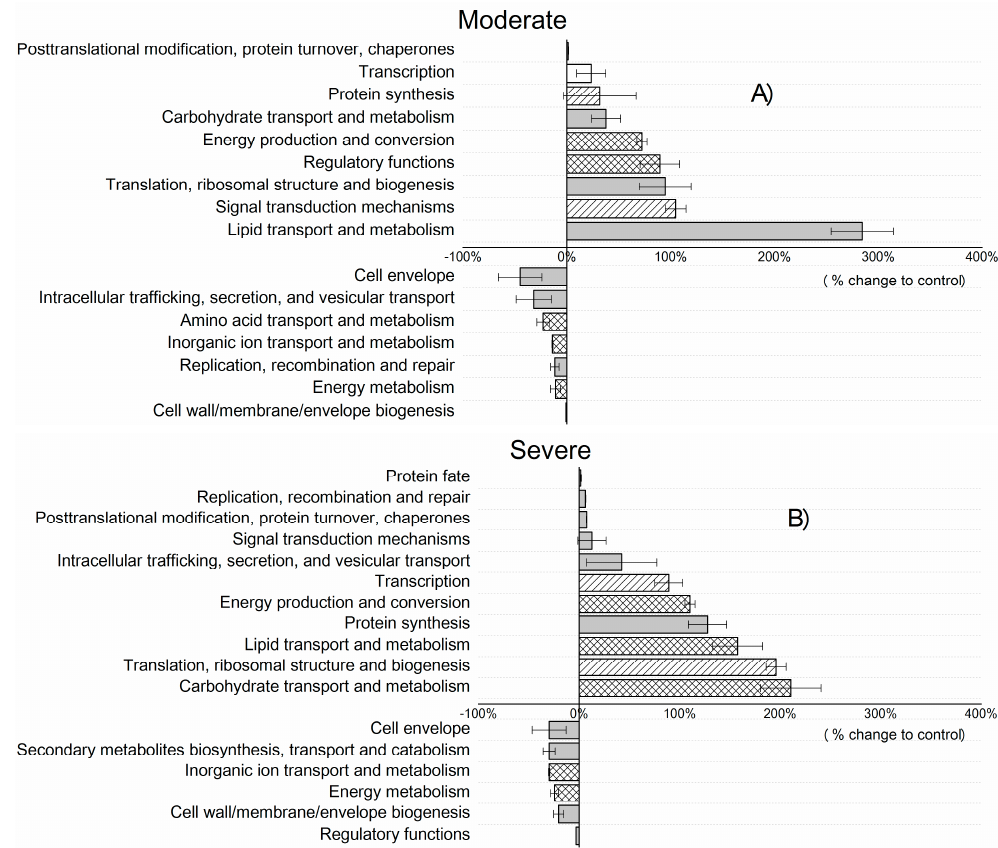
Figure 3. Functional distribution of microbial proteins based on clusters of COG/KOG (Clusters of Orthologous Groups of Proteins/Eukaryotic Ortholog Groups) main/sub role. For COG and KOG functional categories, protein functions are screened only from the origin of bacteria and fungi, respectively, but not for archaea, as such data are so far not available. Relative abundances calculated from the sum of normalized spectral abundance factor (NSAFs) found in the control and DRW plots: (A) moderate DRW treatment (B) severe DRW. Bars are means of two biological replicates and show the % change in relative abundance of the treatment plots compared with the control. In main functional classifications, cellular processes are plain, metabolisms are crosshatched, and information storage and processing are striped from bottom left to top right.